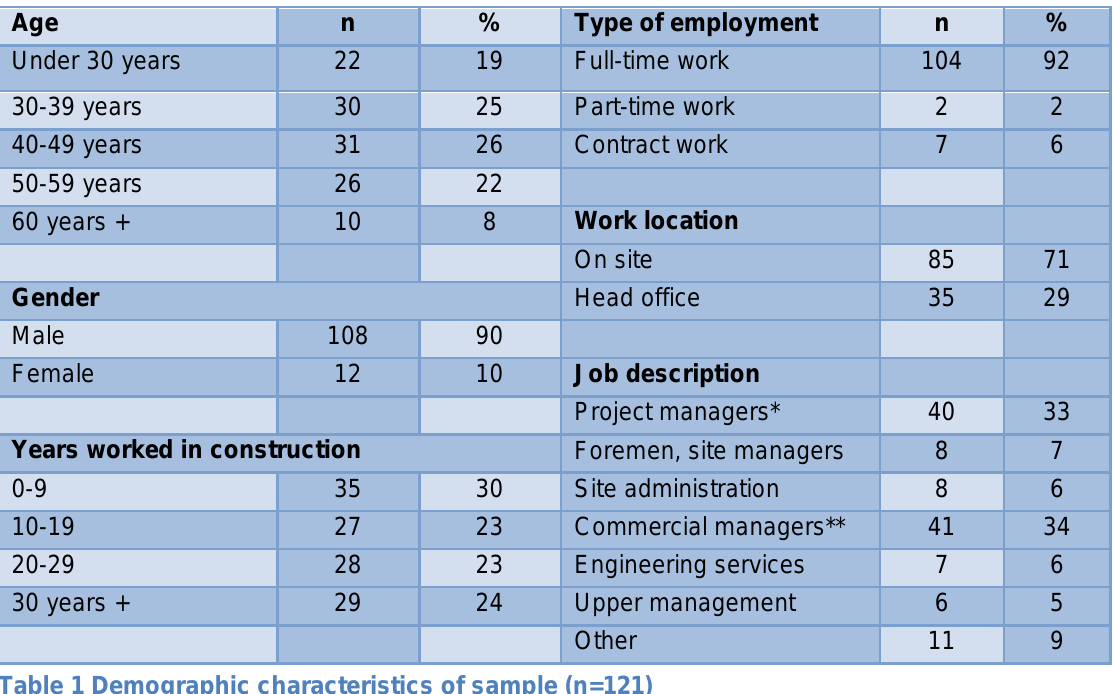
Table 1 Demographic characteristics of sample